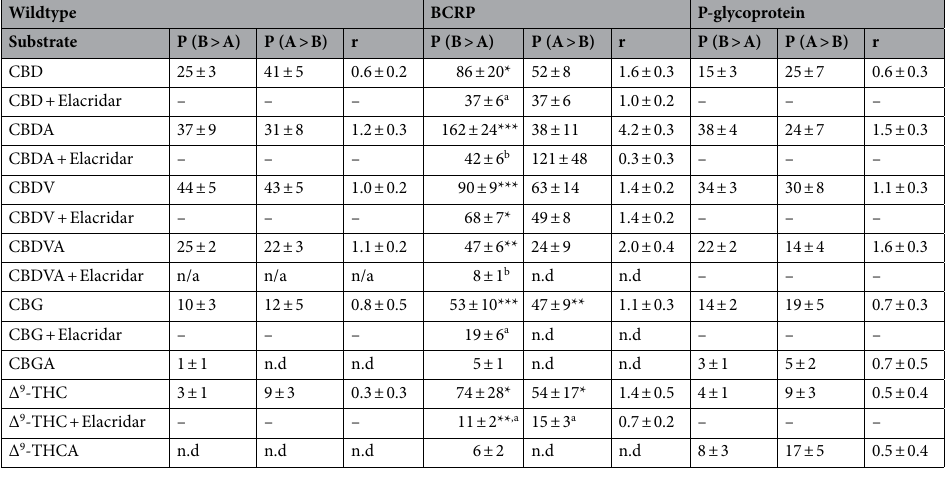
Table 2. Permeabilities of cannabinoids in wildtype, BCRP and P-glycoprotein MDCK cells. P Permeability calculations (× 10 −5 cm/s). n.d. not determined; slope of concentration–time curve was not